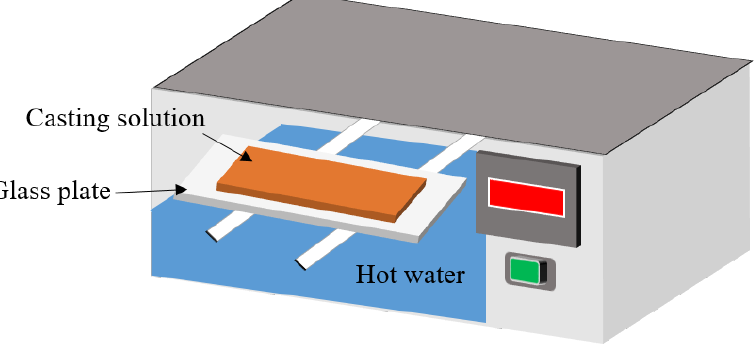
Figure 2. Schematic diagram of PVDF membrane preparation.